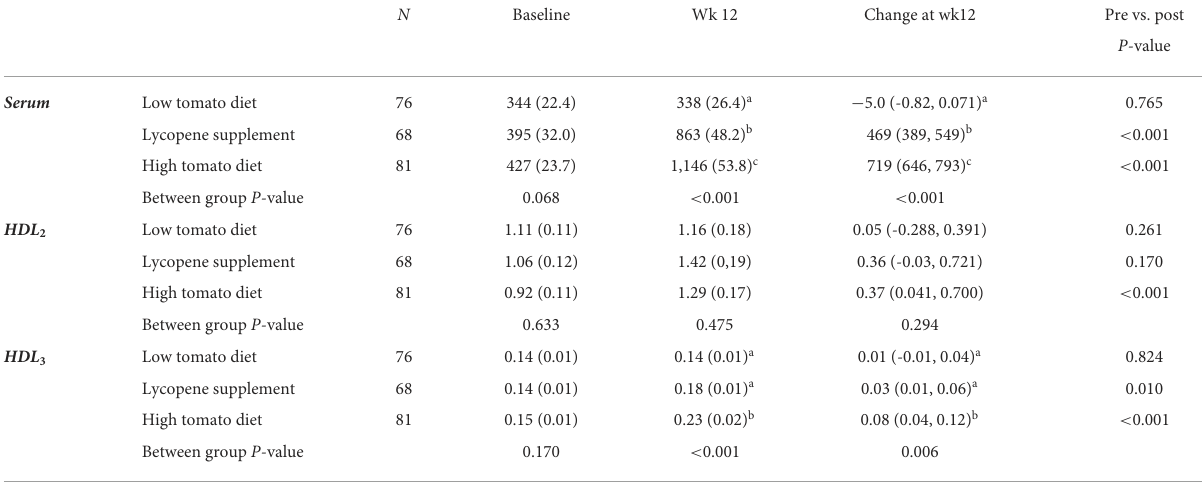
TABLE 3 Lycopene concentration in HDL 2 , HDL 3 , and serum following 12-week intervention with either a low tomato diet, lycopene supplement, or high tomato diet.